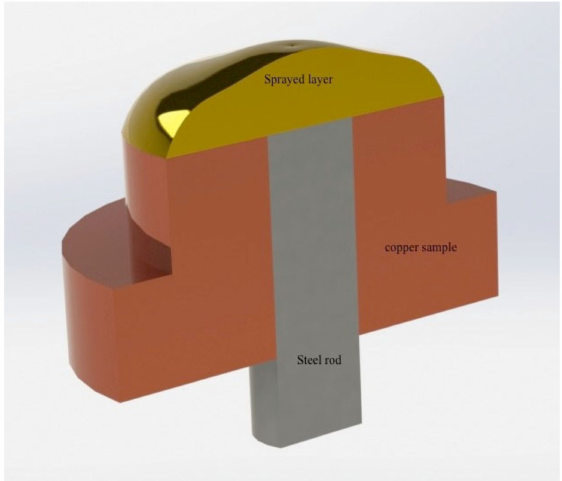
Figure 1. A schematic representation of a specimen for adhesion tests.